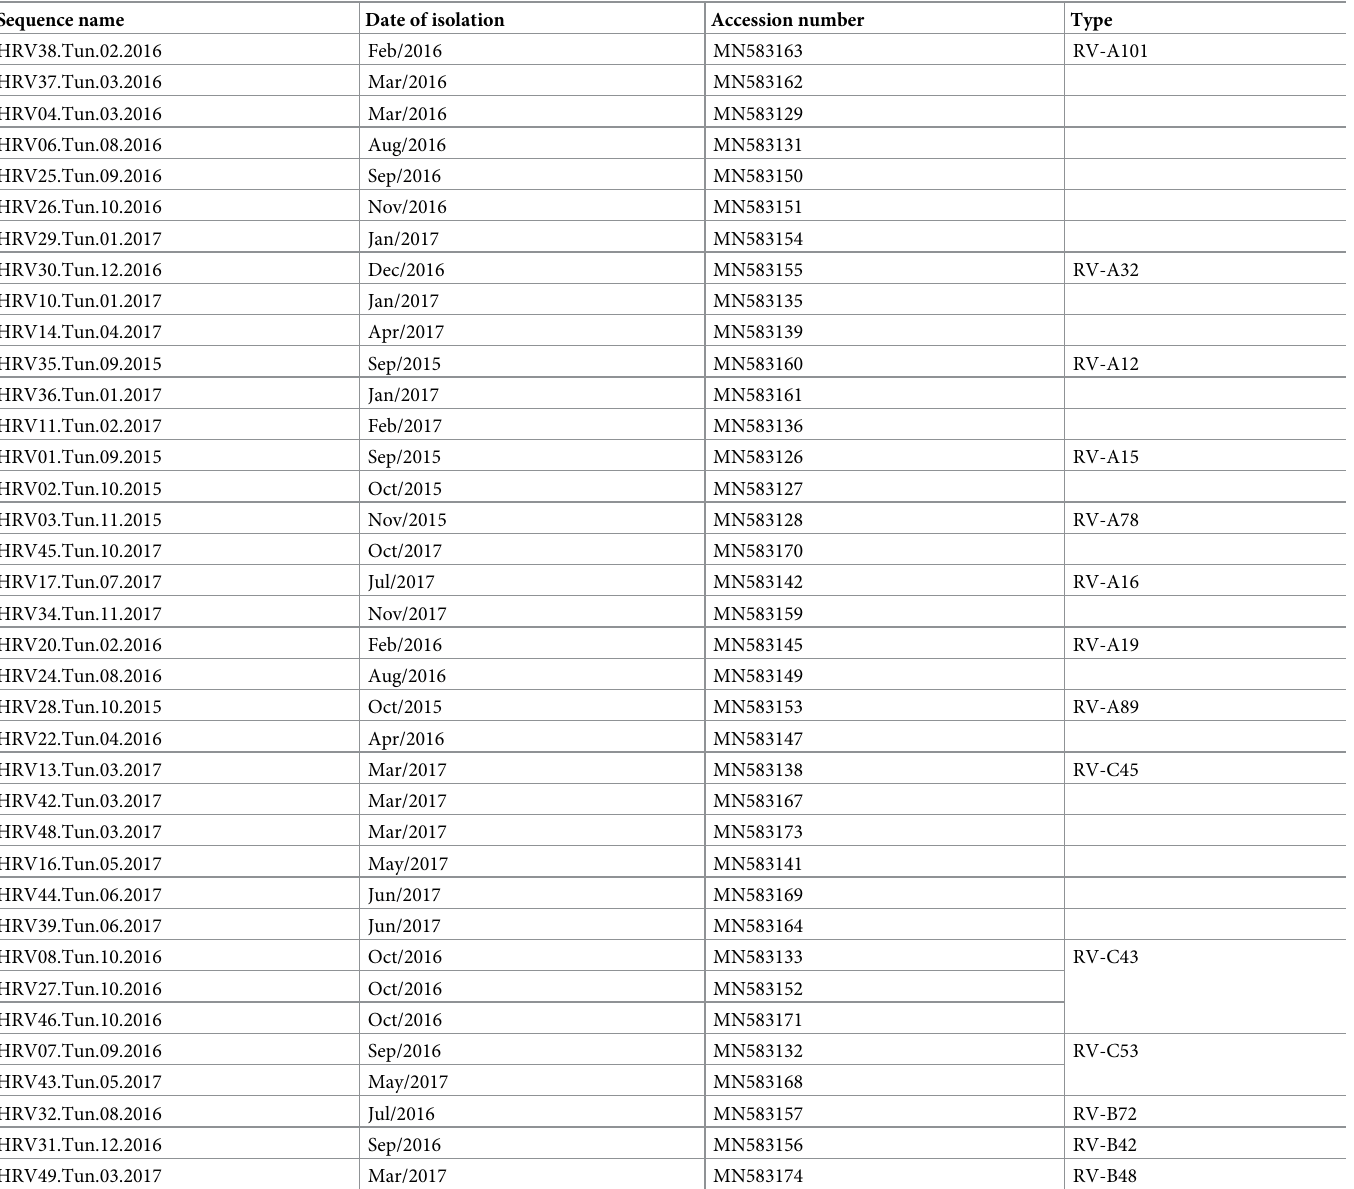
Table 1. Description of Tunisian sequences